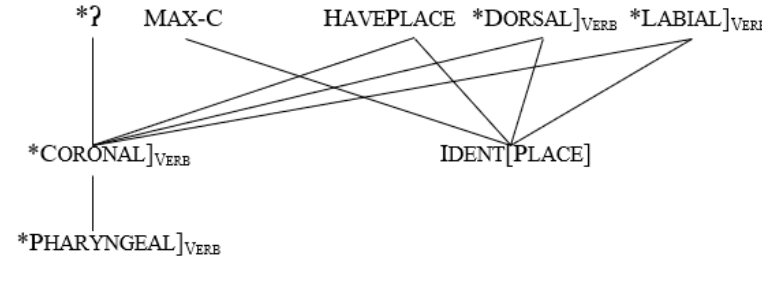
7.2. Non-Coronal as the Default PoA of Latent Segments in Non-Verb Forms Harmonic Alignment (Prince and Smolensky 1993) is a mechanism in OT by which two markedness hierarchies are combined to create two fixed rankings of markedness constraints. The elements in each markedness hierarchy are ordered from the highest degree to the lowest according to some dimension of prominence. One of the markedness hierarchies refers to a linguistic property or structure and the other markedness hierarchy refers to linguistic contexts. Thus, each of the resulting markedness constraints militates against the presence of a linguistic property/structure occurring in a context. The higher a con- straint is ranked within the fixed ranking, the more undesirable the occurrence of that property in the context indicated by the constraint. For instance, Prince and Smolensky (1993, 2004) align the sonority markedness hierarchy (in which vowels are more promi- nent than sonorants and sonorants, more prominent than obstruents, represented as |Vowels > Sonorants > Obstruents|) with a markedness hierarchy on syllable positions (in which the syllable nucleus is more prominent than the syllable margins, represented as |Nucleus > Margins|). The sonority markedness hierarchy provides the linguistic prop- erty while the syllable position markedness hierarchy provides the contexts. The align- ment of the markedness hierarchies proceeds by first combining the most prominent ele- ment of the markedness hierarchy that provides the context with the most prominent el- ement of the markedness hierarchy that provides the linguistic property. Thus, we obtain: Nucleus/Vowels. Then, we continue to combine the same most prominent element of the context-referring markedness hierarchy with the second most prominent element of the property-referring markedness hierarchy, which gives us: Nucleus/Sonorants. This is re- peated until all the elements of the property-referring markedness hierarchy have been combined with the most prominent element of the context-referring markedness hierar- chy. When this procedure is applied to the first element of the markedness hierarchy on syllable positions, the result is the Harmonic Scale displayed in (69). Then, when we get to the other end of the context-referring markedness hierarchy, we start combining its least prominent element with the least prominent element in the other markedness hierarchy. In the case of the markedness hierarchy on syllable positions, the element on the other end of the markedness hierarchy is Margins and it should be first combined with the least prominent element in the sonority markedness hierarchy. Thus, the first combination that we get is: Margins/Obstruents. Then, we combine Margins with the second least promi- nent element in the sonority markedness hierarchy: Margins/Sonorants. At the end, the result is the Harmonic Scale displayed in (70). (69) H Nucleus = Nucleus/Vowels › Nucleus/Sonorants › Nucleus/Obstruents